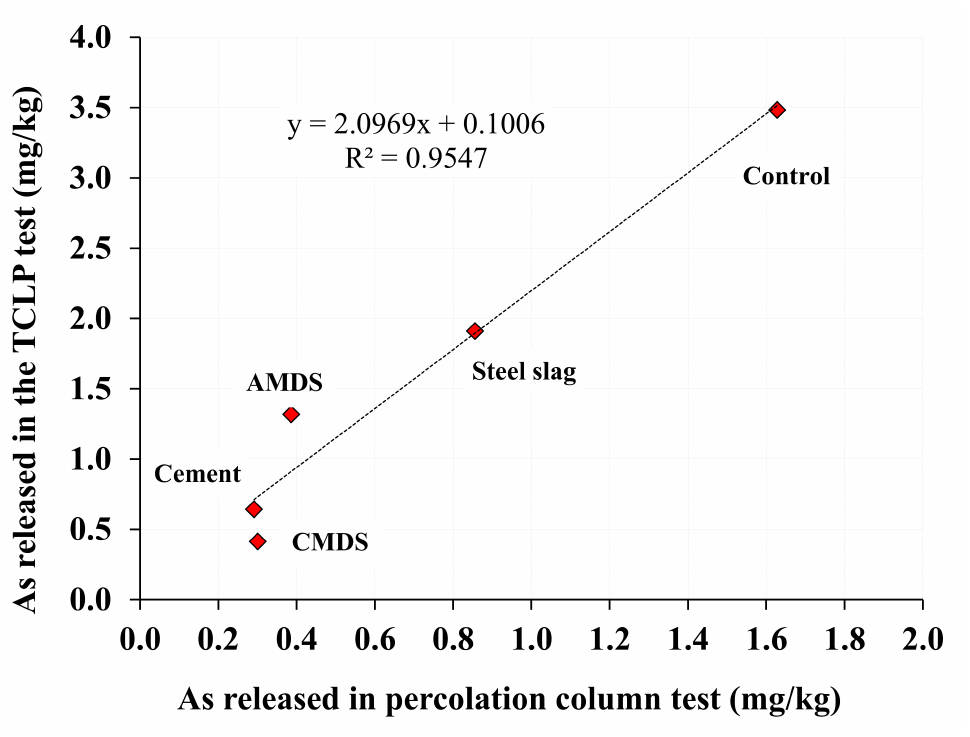
Figure 8. The TCLP vs percolation column test for the release of arsenic from contaminated and stabilized soils. Note that the comparisons are based on the same L/S ratio (i.e., cumulative mass release at 20 L/S for the percolation test and the mass release at 1:20 solid-to-liquid ratio for the TCLP test).